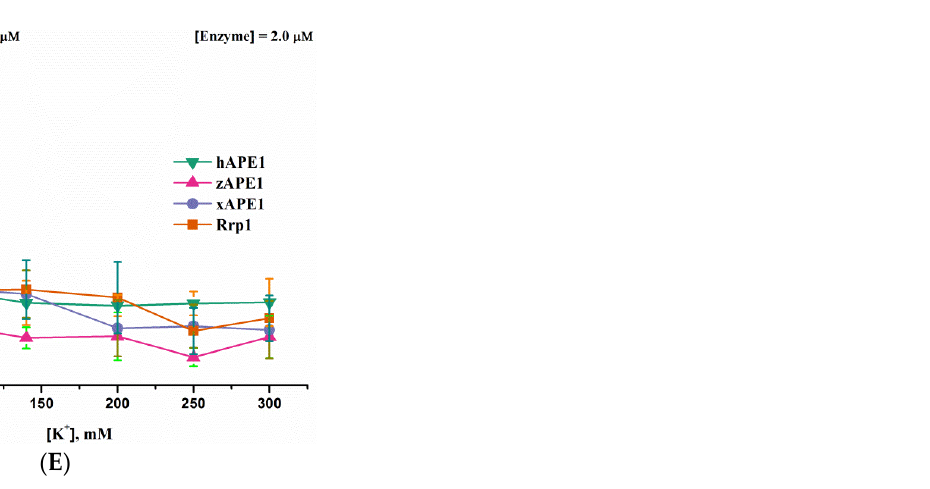
Figure 5. The efficiency of cleavage of the RNA substrate by the four APE1-like enzymes. Positions of the hydrolyzed nucleotides are pointed out by arrows as revealed by RNase A cleavage ( A ). PAGE analysis of the reaction products in the presence of 1.0 mM EDTA ( B ) or 5.0 mM MgCl 2 ( C ). A comparison of the efficacy rates of cleavage of the RNA substrate by the four APE1-like enzymes ( D ). Dependences of the RNA cleavage efficacy on K + concentration ( E ). Error was calculated by averaging each data point over at least three replicates. Enzyme = 2.0 μ M, RNA = 1.0 μ M, and reaction time = 1 h.